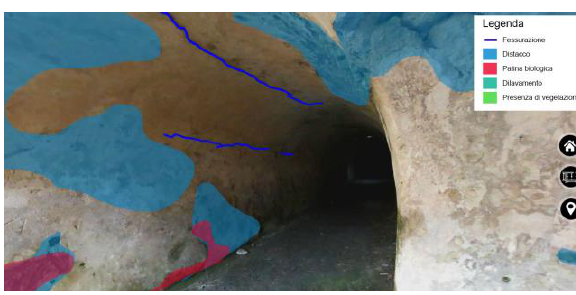
Figure 10. Spherical visualization of the n3